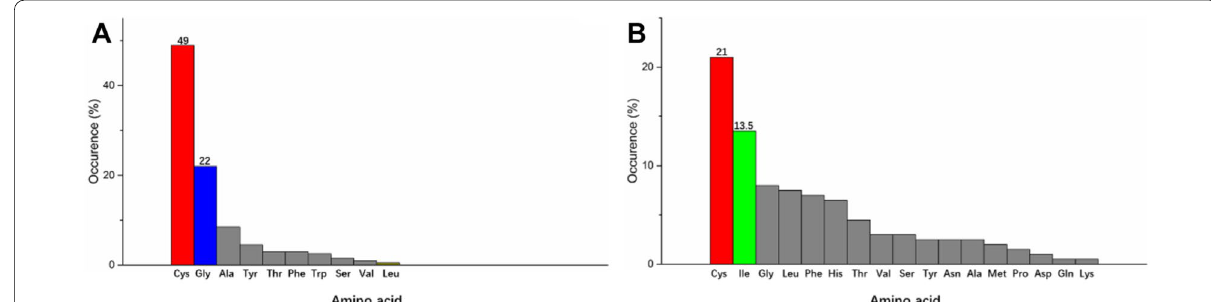
Fig. 5 Occurrence of different amino acids at the residue positions of 160 and 180, respectively. Glycine is the second most occurred residue at the position 160 ( A ), and isoleucine is the second most occurred residue at the position 180 ( B )